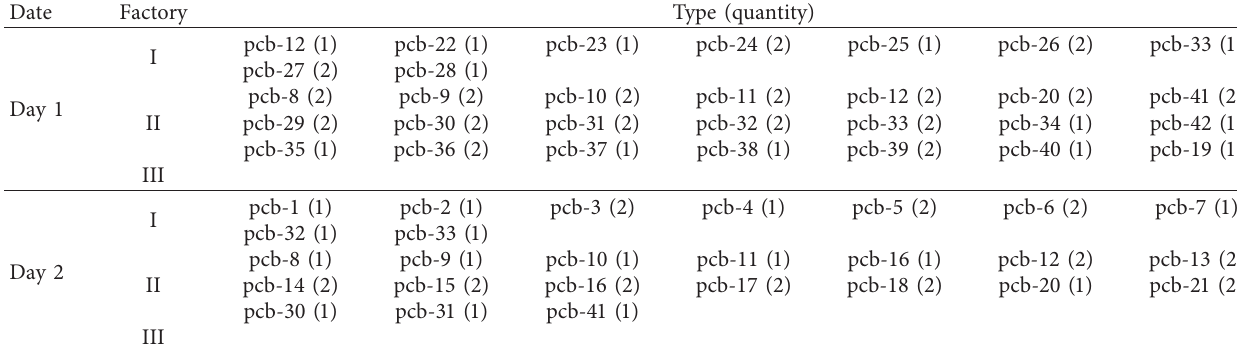
Table 2: Optimized PC component transportation plan.